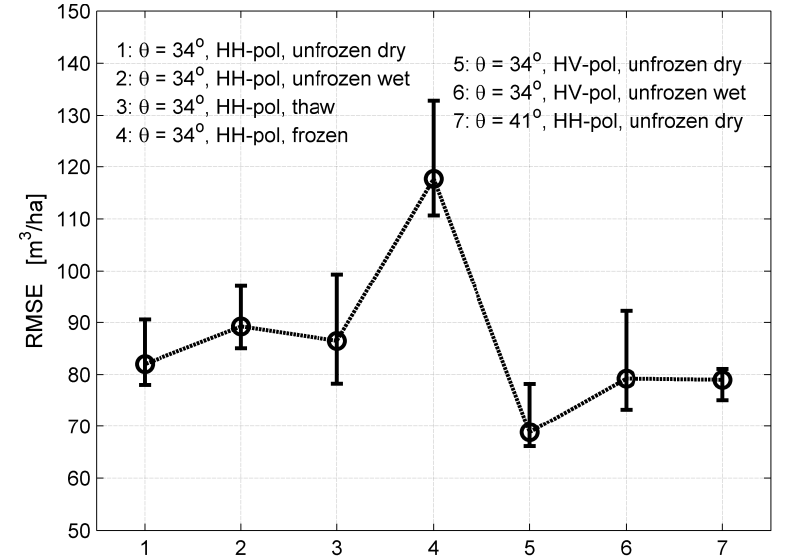
Figure 10. Distribution of single-image retrieval RMSE at Krycklan for combinations of look angle, polarization and environmental conditions for which multi-temporal SAR backscatter observations (at least three) were